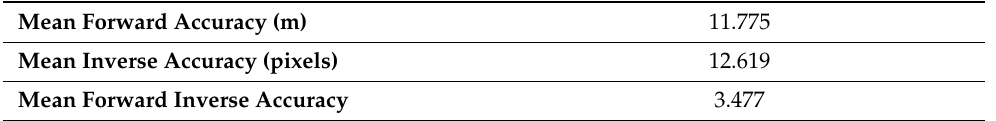
Table 4. Mean accuracy of final Corona